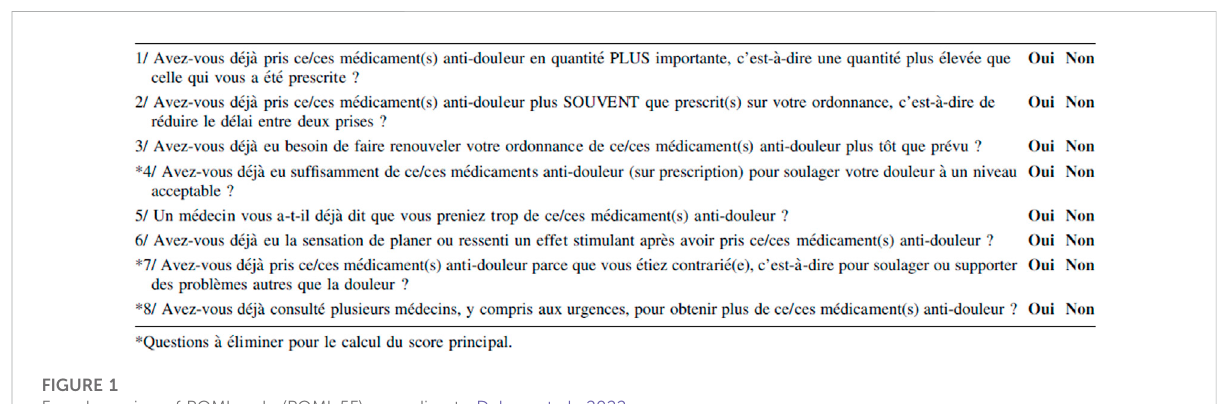
FIGURE 1 French version of POMI scale (POMI-5F) according to Delage et al.,